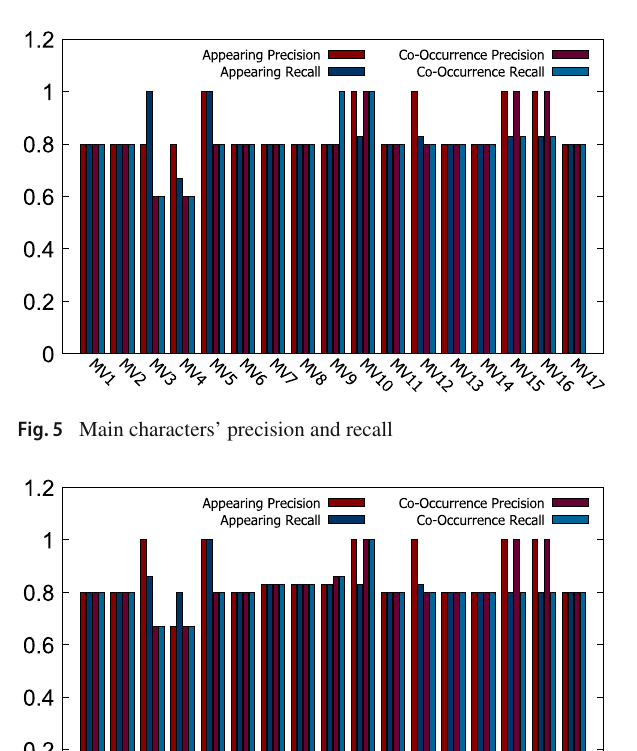
Fig. 4 The centralities measurement results using number of appear- ances time of characters